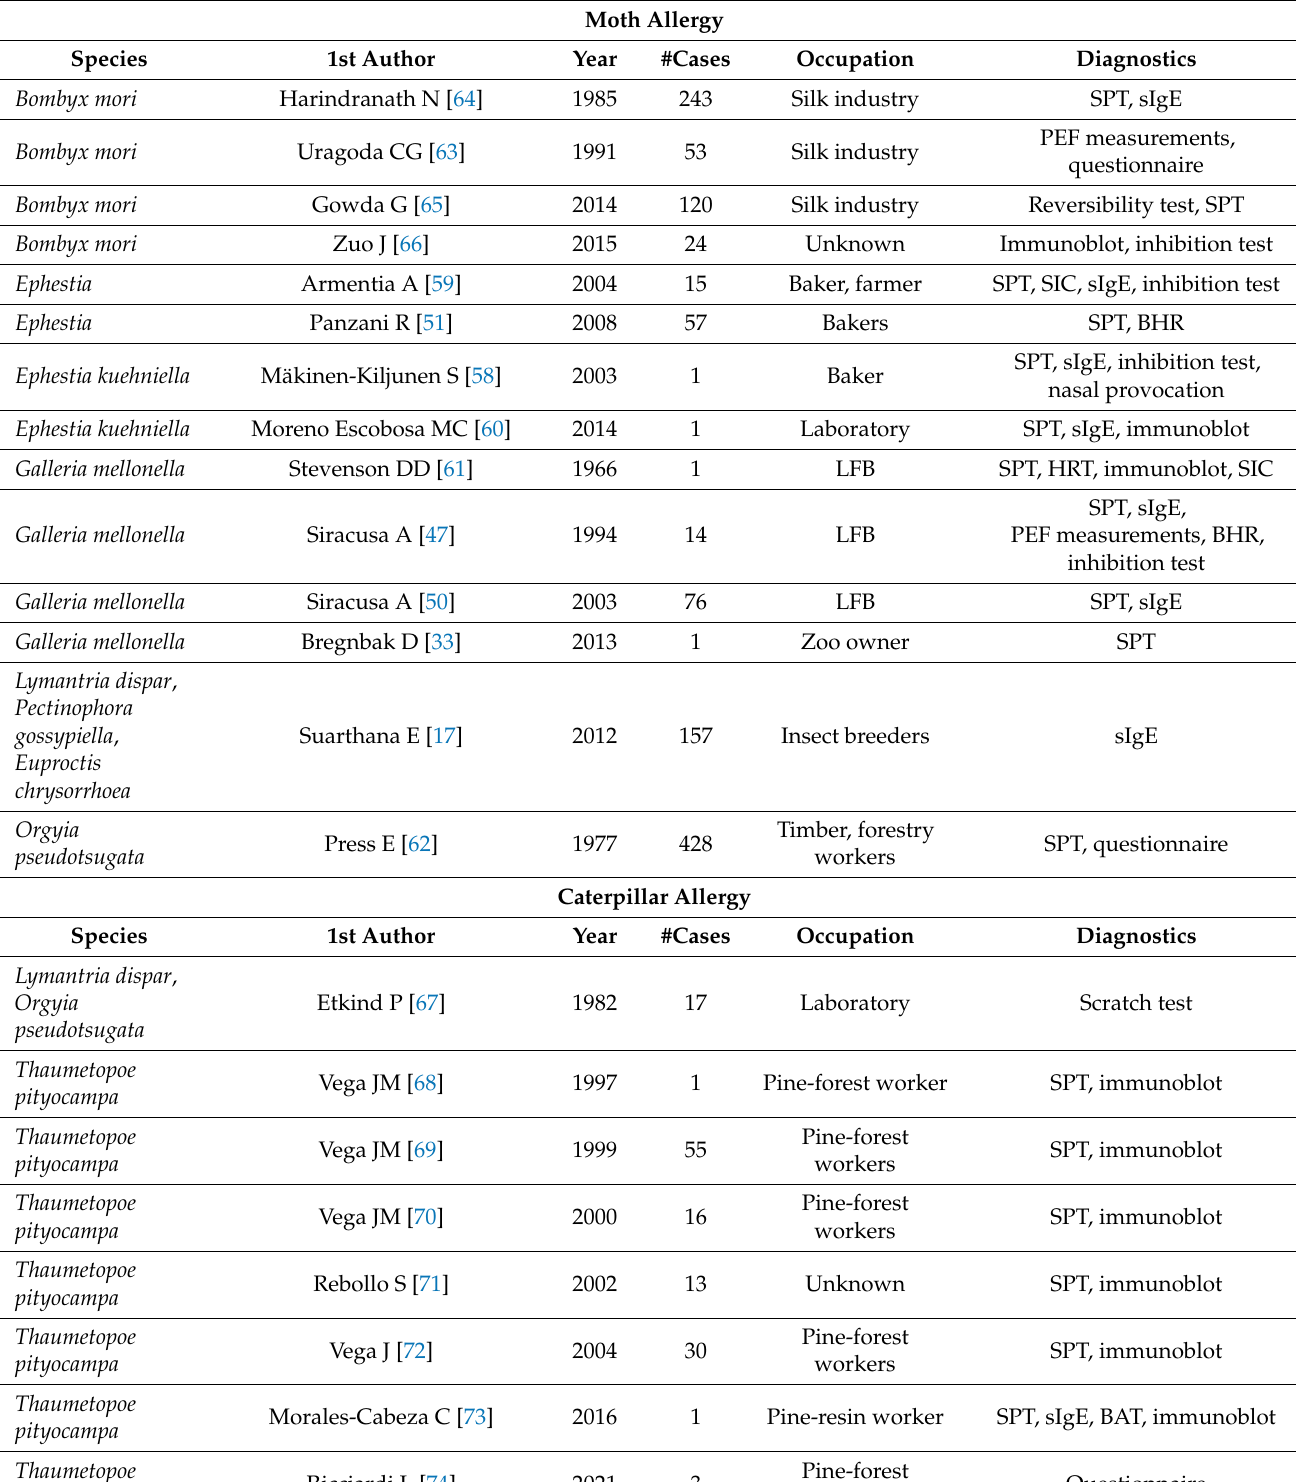
Table 3. Lepidoptera allergy.